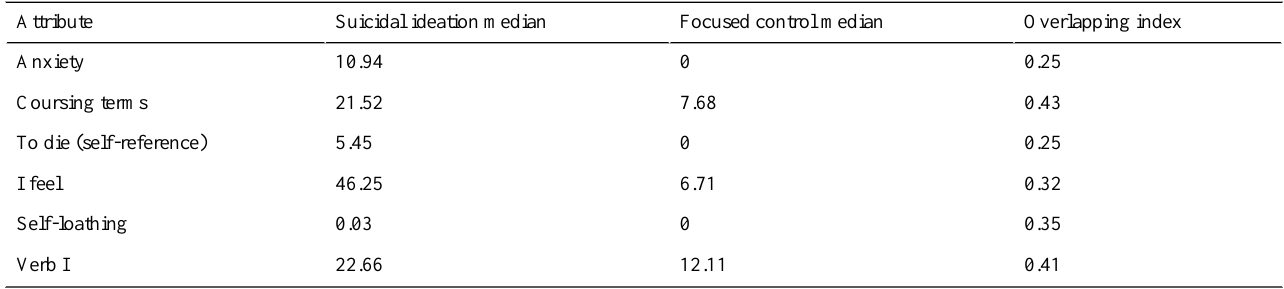
Table 6. Medians and Distribution Overlapping Index for some of the attributes with the most significant differences between the Suicidal ideation and Focused control groups.